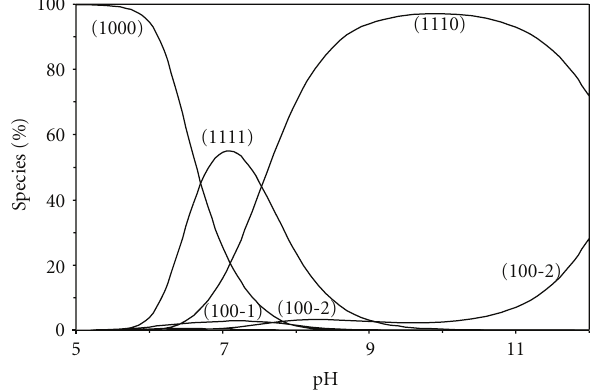
Figure 8: Concentration distribution of various species as a func- tion of pH in the [Zn(BAPP)(glutamic acid)] system (1.25 mM of Zn 2+ , BAPP, and glutamic acid).